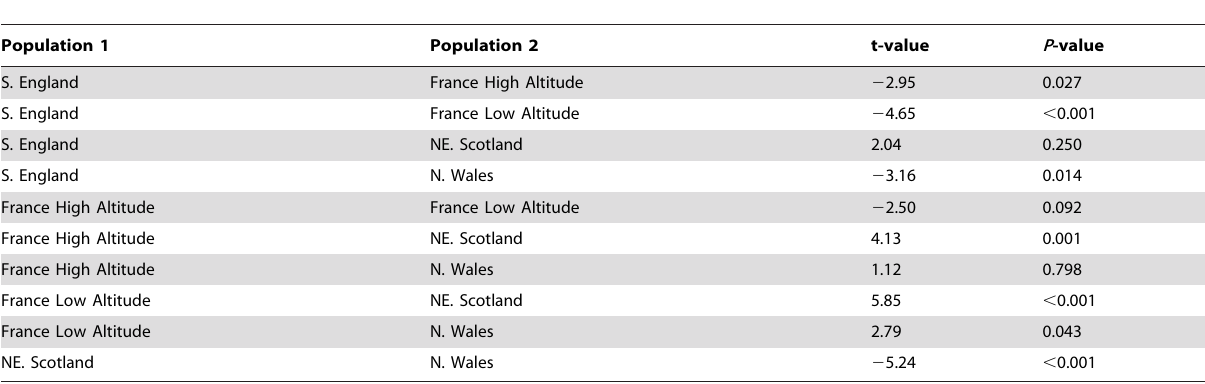
Table 2. Results of Tukey-Kramer comparisons of the least square mean temperature at initiation of questing between tick populations.